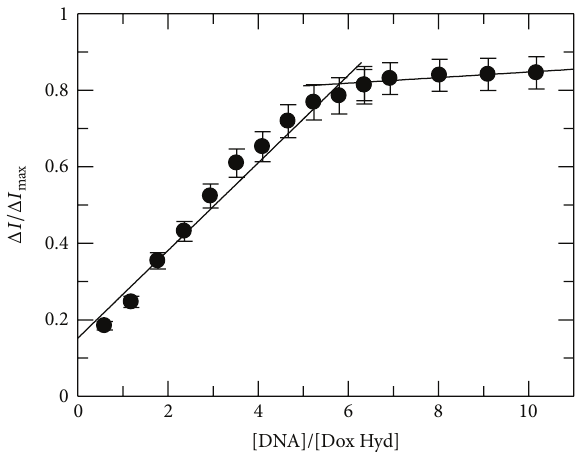
Figure 7: Plot of normalized increase of cathodic peak current as a function of mole ratio of CT DNA to doxorubicin hydrochloride.